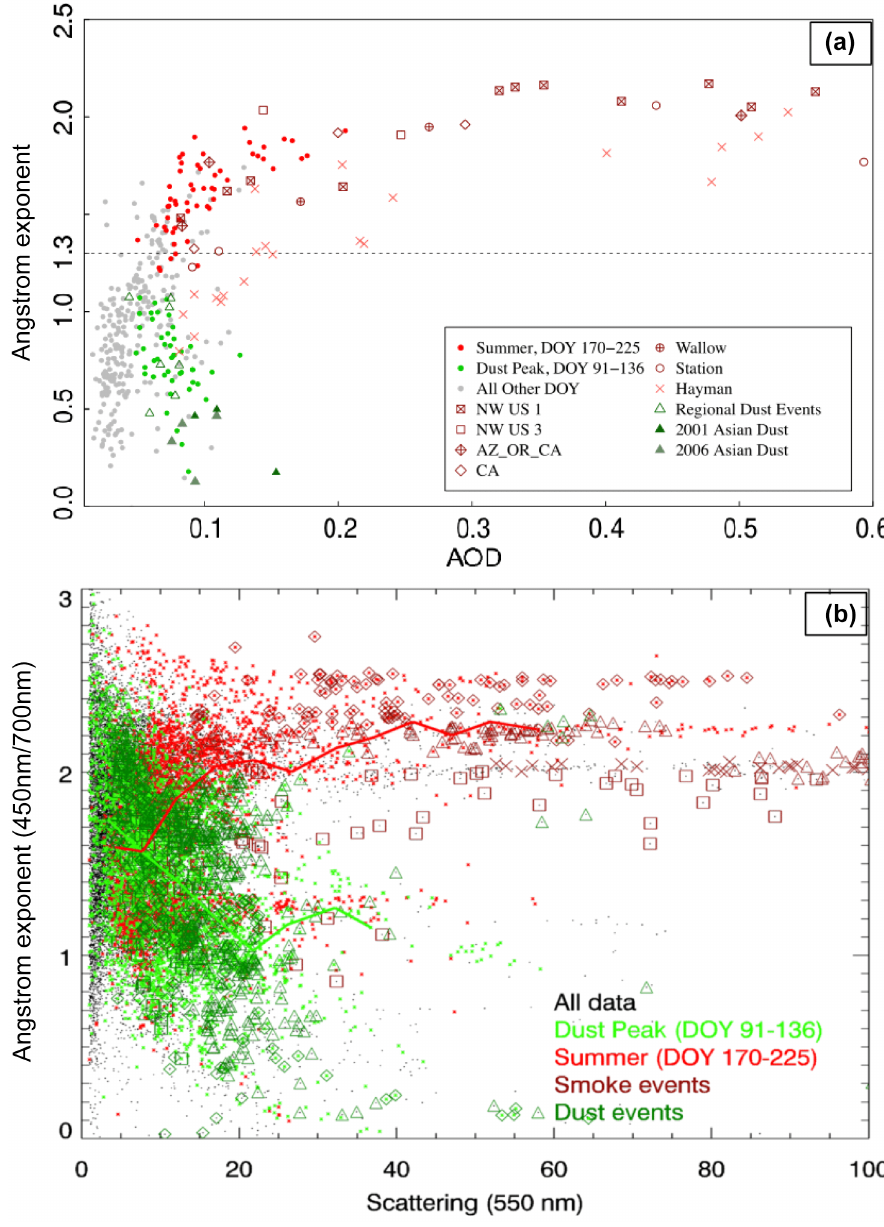
Figure 4. (a) AOD vs. Ångström measurements for vis-MFRSR. The dots represent daily-averaged measurements for the entire 1999–2011 and 2013 period of observation. The red indicates all measurements made from DOY 170 to 225 during peak summer season. Green indicates all measurements made during DOY 91–136, spring dust peak. The gray points indicate all measurements that were not made during these spring and summer periods. Events listed in Table 1 are shown with larger symbols; dust events are dark green, and fire events are maroon. (b) Relationship between hourly averaged Ångström exponent and scattering from the 2011–2013 nephelometer measurements. The lines represent the median value of Ångström and scattering for each scattering bin for either the dust peak or summertime range. The scattering bin limits are: [ 1 , 5 , 10 , 15 , 20 ,..., 95 , 100 ] and at least 15 valid data points are required in each scattering bin to generate a line segment. Regional dust events from Table 1 are shown in dark green; smoke events from Table 1 are shown in maroon. For the dust events, diamonds represent data from 2011, triangles 2012, and squares 2013. For the smoke events, the Wallow fire is indicated by squares, the Front Range fire is indicated by diamonds, the NW1 fire is indicated by triangles, and the NW2 fire is indicated by x